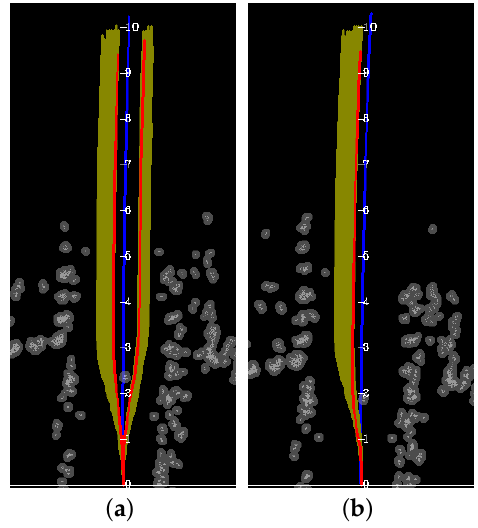
Figure 23. The generated trajectories and the selected suboptimal trajectories for each driving maneuver. ( a ) The generated trajectories at time t 1 . ( b ) The generated trajectories at time t 2